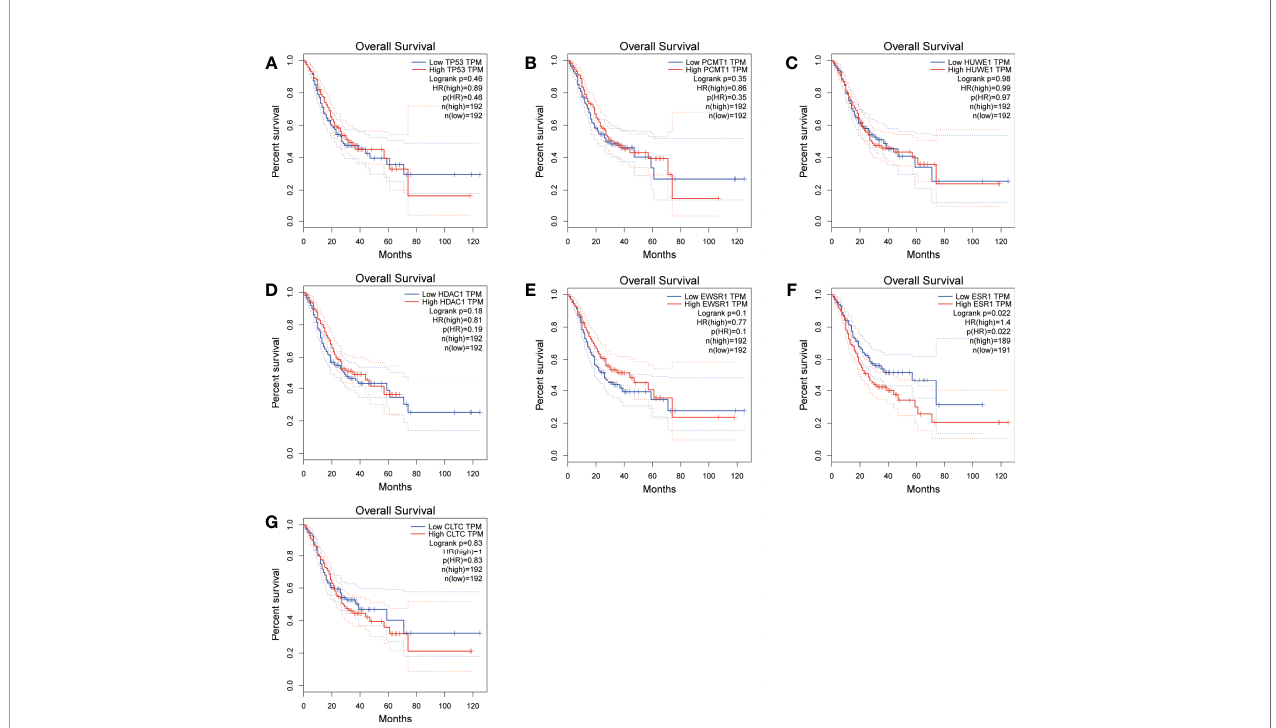
FIGURE 11 | Overall survival (OS) analysis of the seven hub genes in STAD patients from the GEPIA2 database. (A) Survival analysis for TP53 in STAD. (B) Survival analysis for PCMT1 in STAD. (C) Survival analysis for HUWE1 in STAD. (D) Survival analysis for HDAC1 in STAD. (E) Survival analysis for EWSR1 in STAD. (F) Survival analysis for ESR1 in STAD. (G) Survival analysis for CLTC in STAD. The patients were strati fi ed into a high-level group (red) and a low-level group (blue) according to the median expression of the gene. Log-rank P < 0.05 was considered to be a statistically signi fi cant difference.